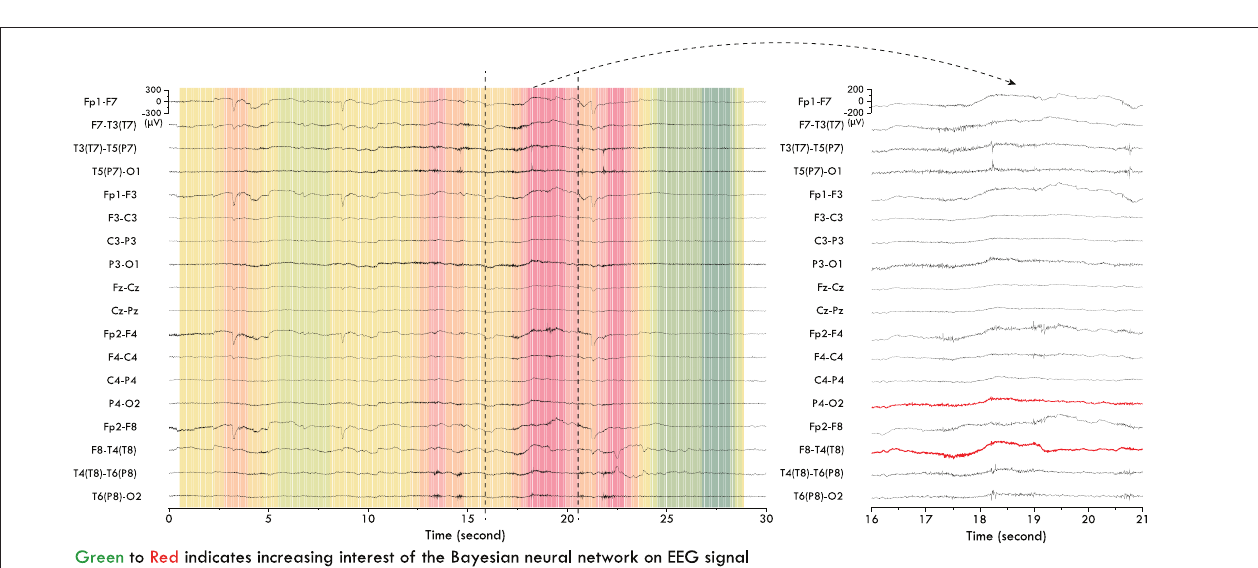
FIGURE 7 | Slow EEG activity as potential bio-marker detected by Bayesian convolutional neural network (BCNN) for epileptic seizure forecasting. Red channels (on the right) were labeled as origin of seizure in the EPILEPSIAE dataset.